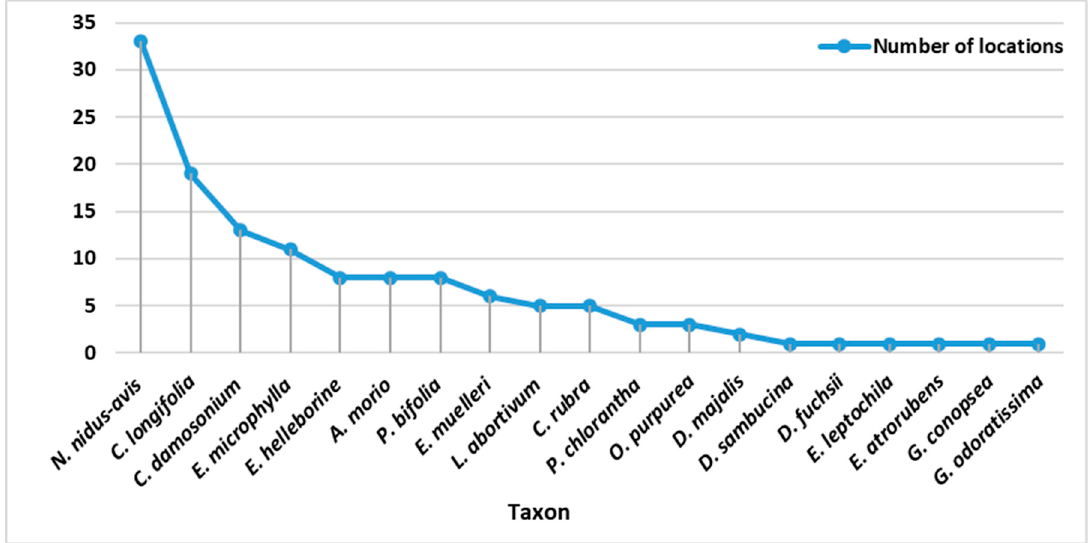
Figure 3. Taxa and number of detected localities.